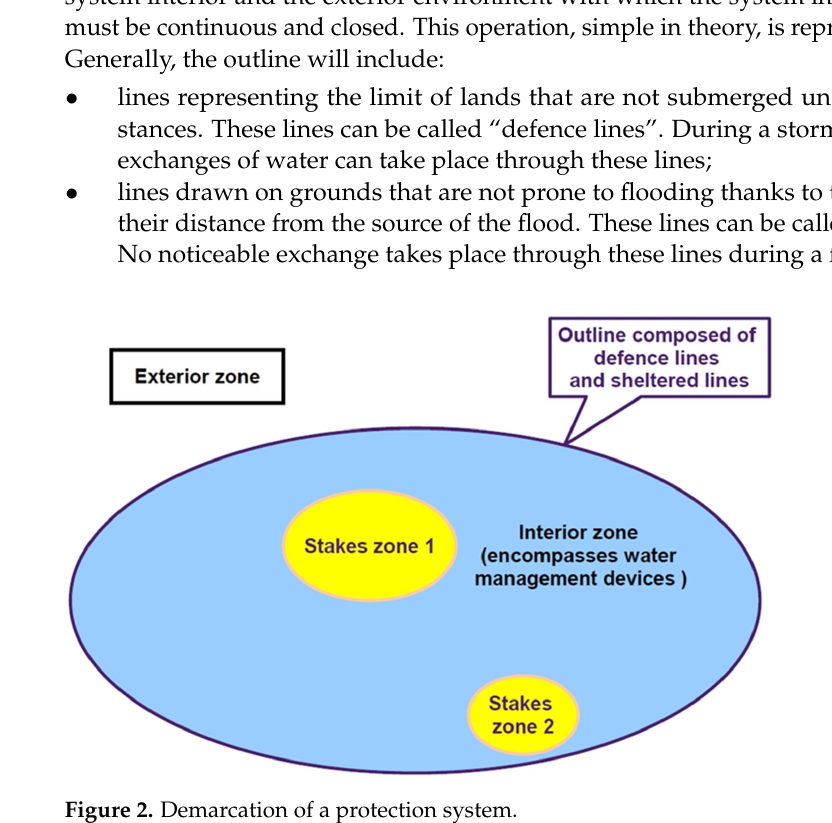
Figure 2. Demarcation of a protection system.